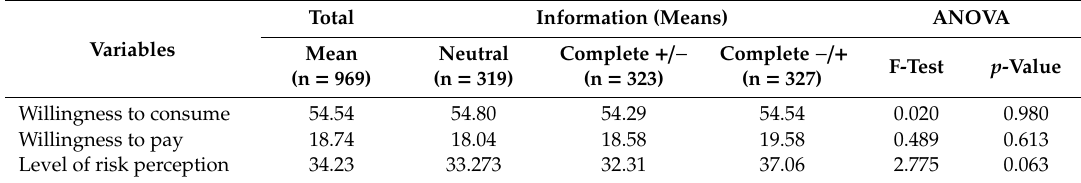
Table 3. One-way ANOVA results for consumers’ willingness to consume, willingness to pay, and level of perception of risks for consumers’ health tied to immunocastration (answers were expressed on a 0-to-100 scale) after receiving di ff erent levels and complexity of information.